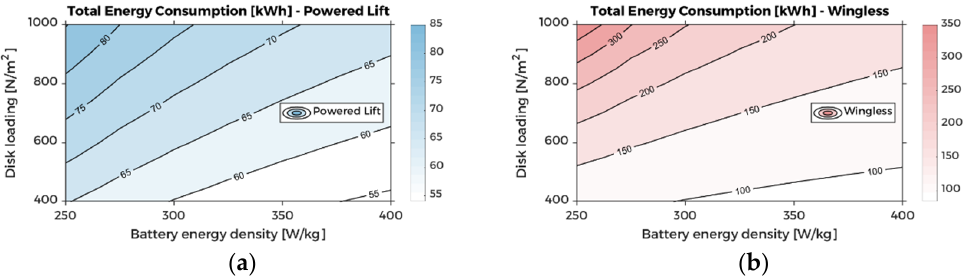
Figure 9. Battery energy density vs. disk loading sensitivity plots for ( a ) powered lift and ( b ) wingless energy consumption.